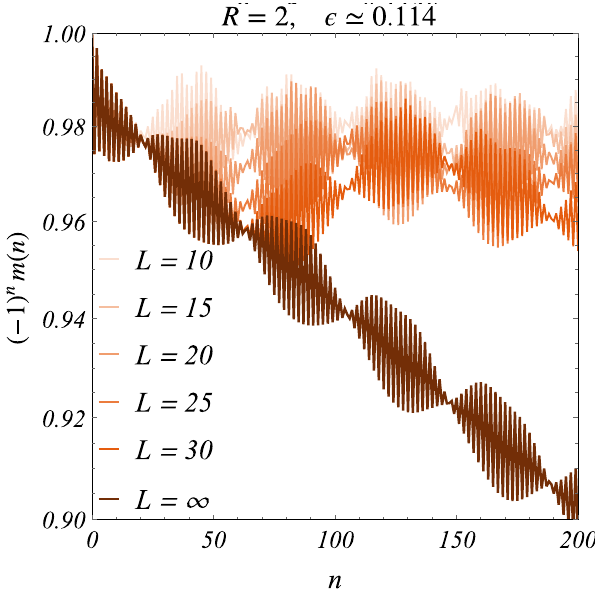
FIG. 12. Same as in Fig. 11(a), for ϵ ¼ 0 . 11390625 . The iTEBD data (thick dark line) are compared with ED for a finite system with different sizes L ¼ 10 , 15, 20, 25, 30 (shaded red lines, from lighter to darker).